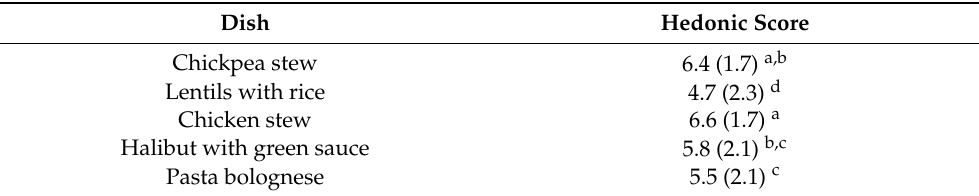
Table 1. Hedonic scores (Mean and SD) of the texture-modified dishes evaluated by the non- dysphagic judges ( n =